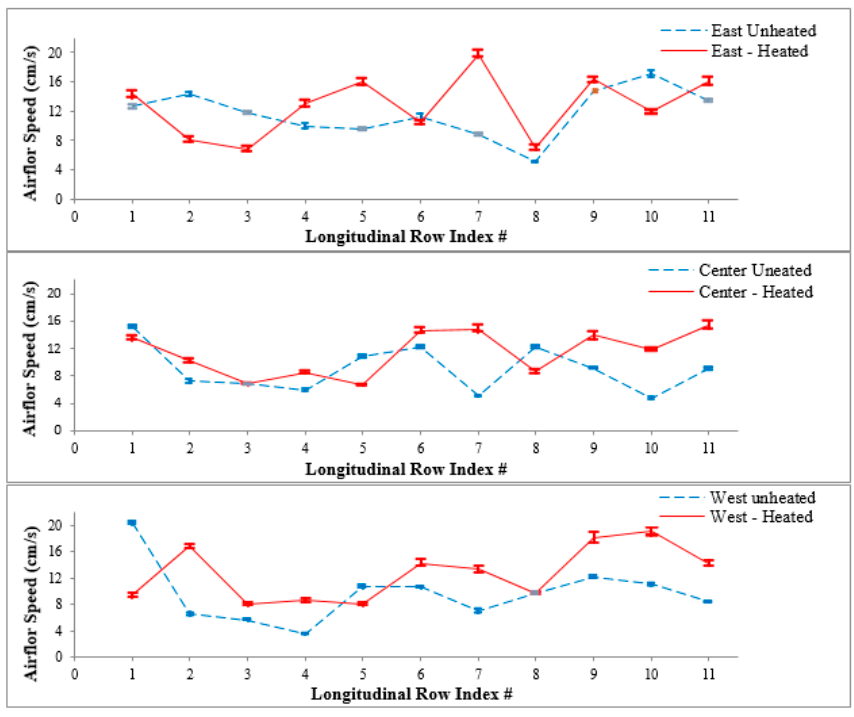
Figure 9. Comparison of the speed with heated and unheated manikins in east, centerline, and west side seats.